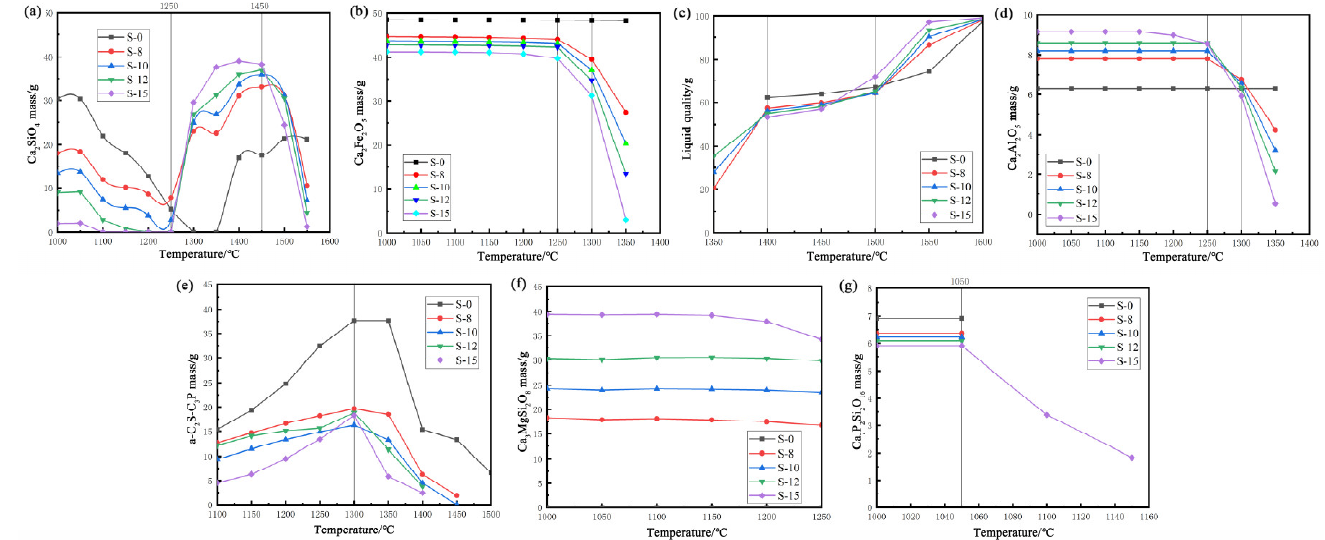
Figure 7. Equilibrium phase composition of tempered slag. ( a – g ) are the masses of Ca 2 SiO 4 , Ca 2 Fe 2 O 5 , liquid quantity, Ca 2 Al 2 O 5 , a‑C 2 S‑C 3 P, Ca 3 MgSi 2 O 8 , and Ca 7 P 2 Si 2 O 16 in the material phase at equilibrium,